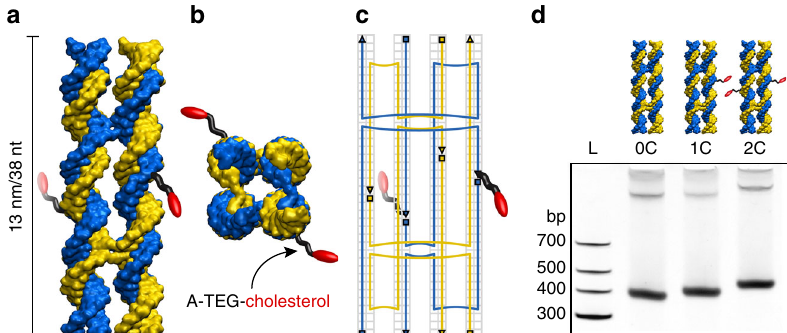
Fig. 1 Design of the lipid-scrambling DNA nanostructure. a Side and b top view of a 3D representation of the assembled DNA nanostructure. Complementary DNA strands are displayed in blue and yellow. Cholesterol modi fi cations (red) at two speci fi c locations are covalently bound to the DNA via an adenine-triethyleneglycol linker (A-TEG, black). c 2D schematic illustrating the pathway of the DNA single strands as well as crossover and modi fi cation positions. Triangles and squares denote the 3 ′ and 5 ′ ends of the strands, and the background grid speci fi es locations of individual nucleotides. d Non-denaturing 10% PAGE of DNA nanostructures annealed without (0C), with one (1C) or with two (2C) cholesterol modi fi cations next to a DNA molecular weight ladder (L). The highest intensity band corresponds to a major population of monomeric structures. The low intensity bands suggest the presence of small amounts of dimers and